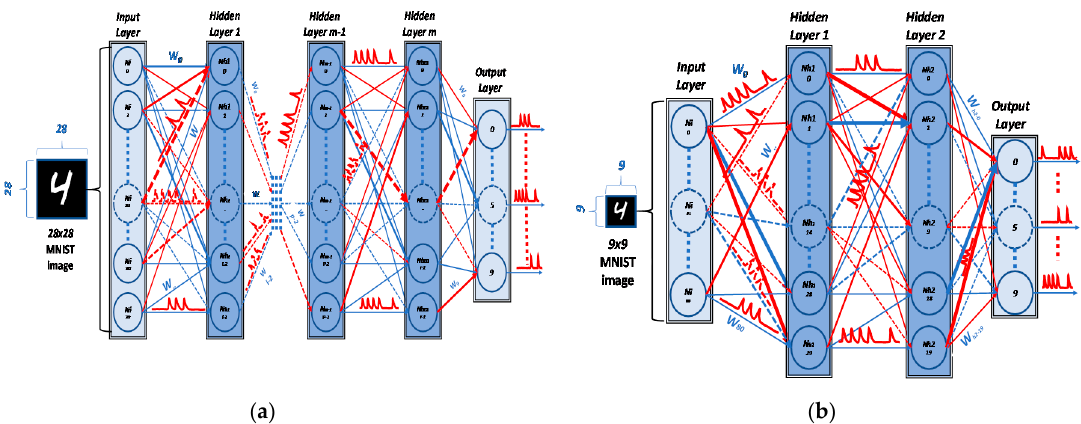
Figure 1. Spiking neural network (SNN) structure: ( a ) SNN structure (m hidden layers) for Modified National Institute of Standards and Technology (MNIST) dataset 28 × 28; ( b ) SNN structure (two hidden layers) for MNIST dataset 9 × 9. In the ( a , b ), red synapse color represents Excitatory synapses and blue for Inhibitory one, the bold line indicates more positive (Excitatory) or more negative (Inhibitory) values.